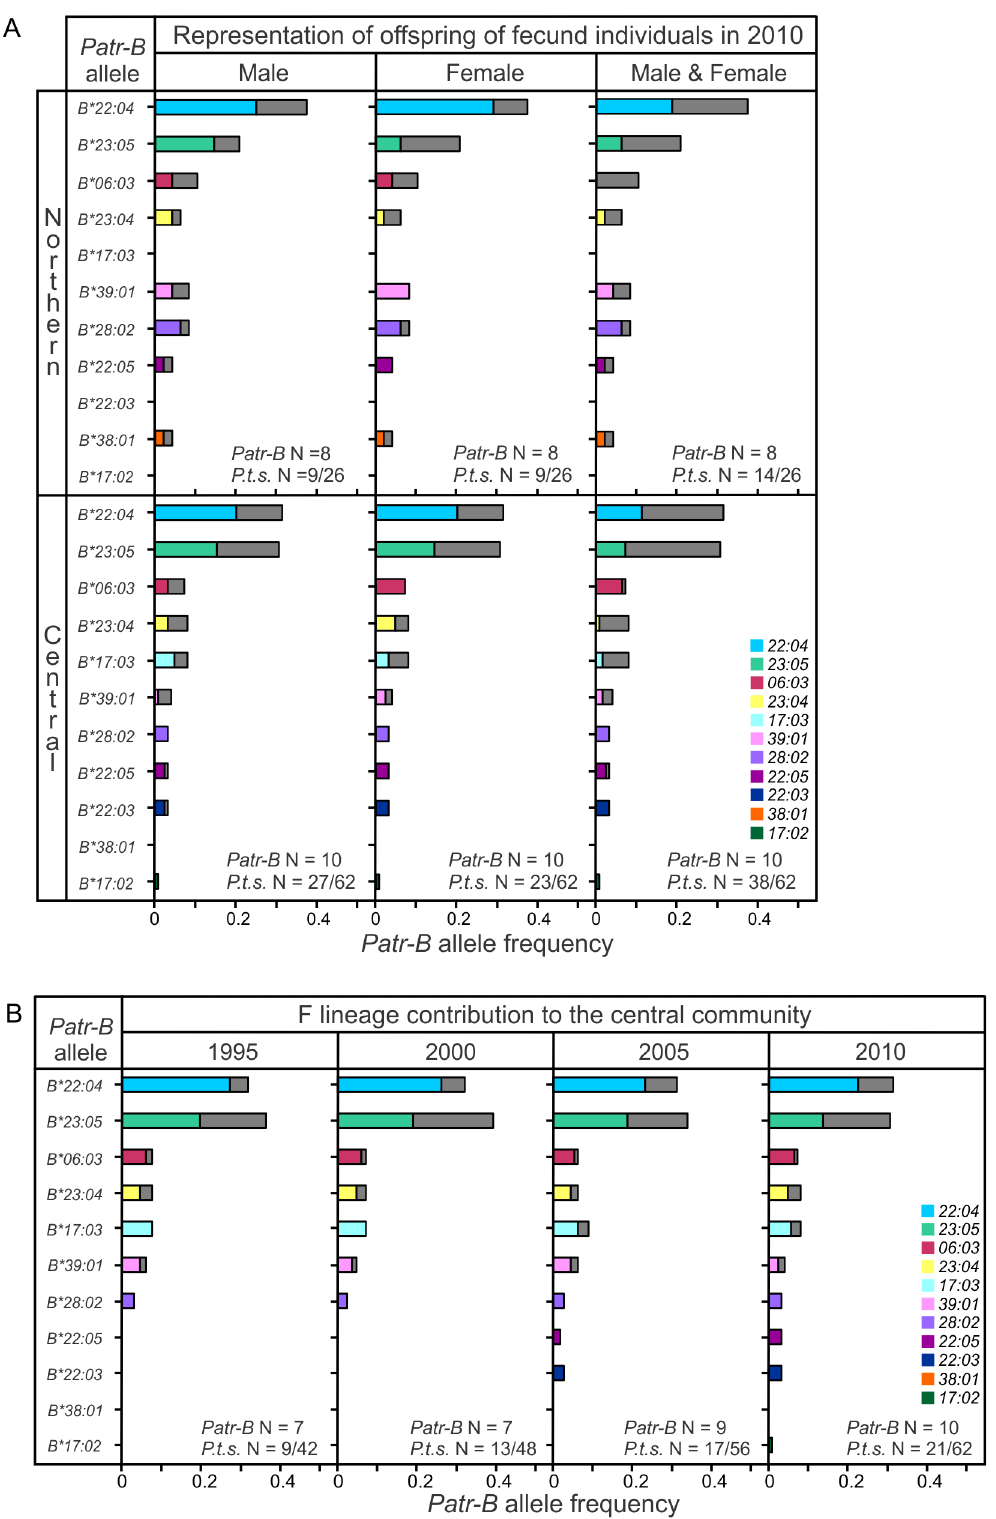
Fig 11. Fecundity of socially dominant chimpanzees is most influential in Gombe ’ s central community. (A) Contribution of the offspring of fecund individuals to the 2010 Patr-B allele frequencies of the northern and central communities. Partial gray shading of the frequency bars gives the